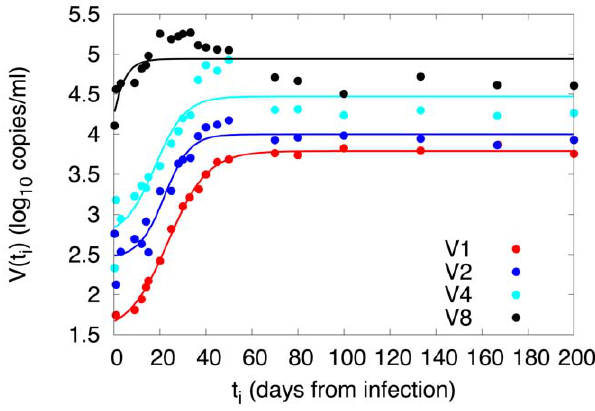
Figure 3. Virological rebound after stopping HAART. Virological rebound at 1, 2, 4 and 8 weeks after therapy interruption for different starting time points of HAART ( t i ). Dots represent the results of thousands simulations. The fitting lines are given by the Richards’ curve in equation 1. Standard deviation is about 0.1 log 10 copies = ml ð Þ for all points. doi:10.1371/journal.pone.0015294.g003 PLoS ONE |